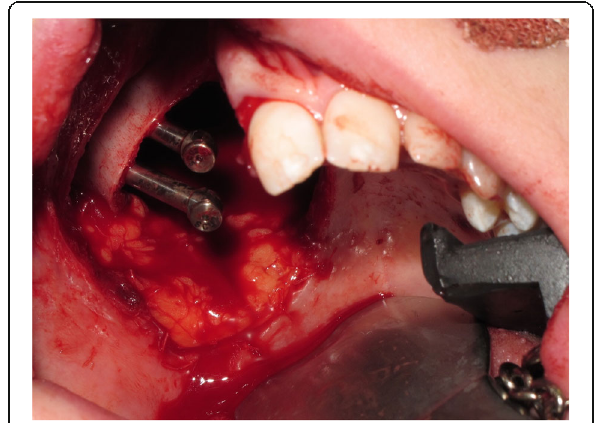
Fig. 3 Low-level right-sided maxillectomy with the insertion of two zygomatic oncology implants at time of surgery